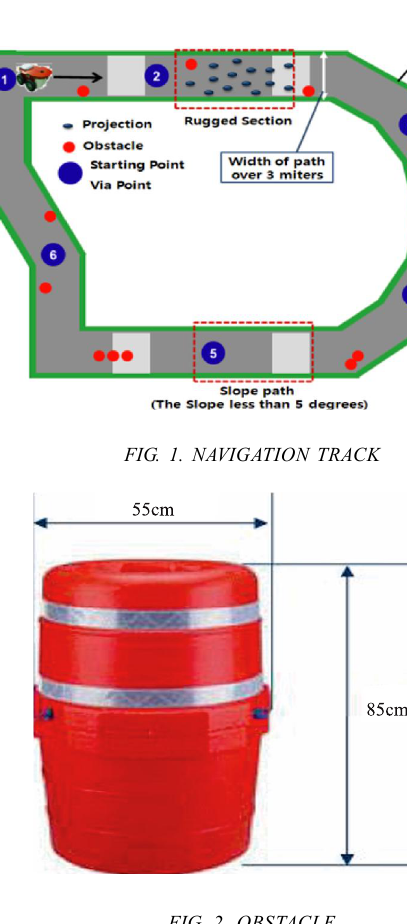
FIG. 3. KINEMATIC DESCRIPTION OF 4-WHEELED MOBILE